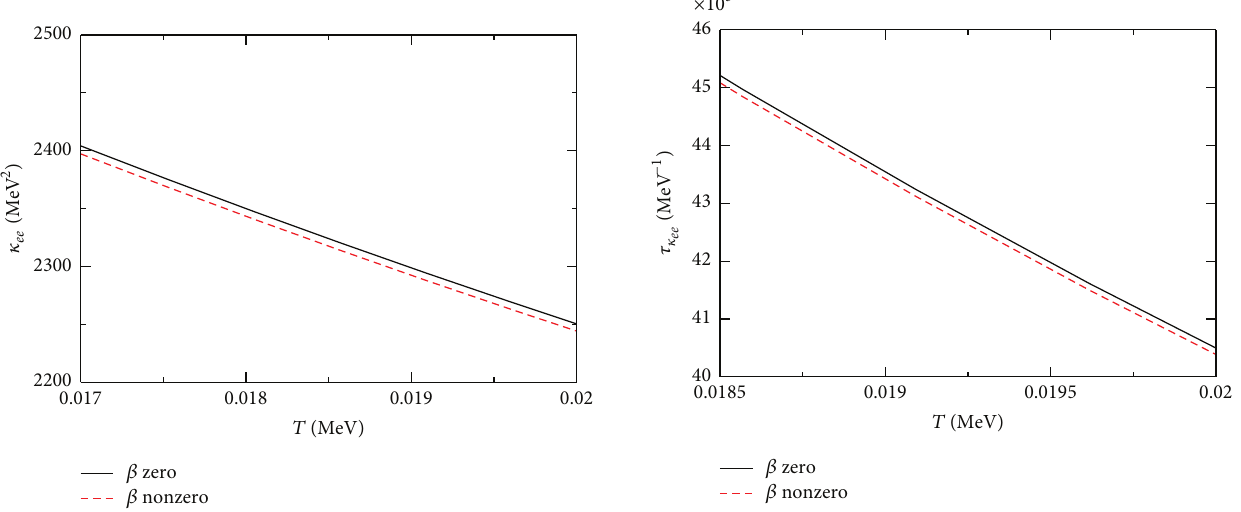
Figure 9: The reduction of 𝜅 𝑒𝑒 with the inclusion of 𝛽 .